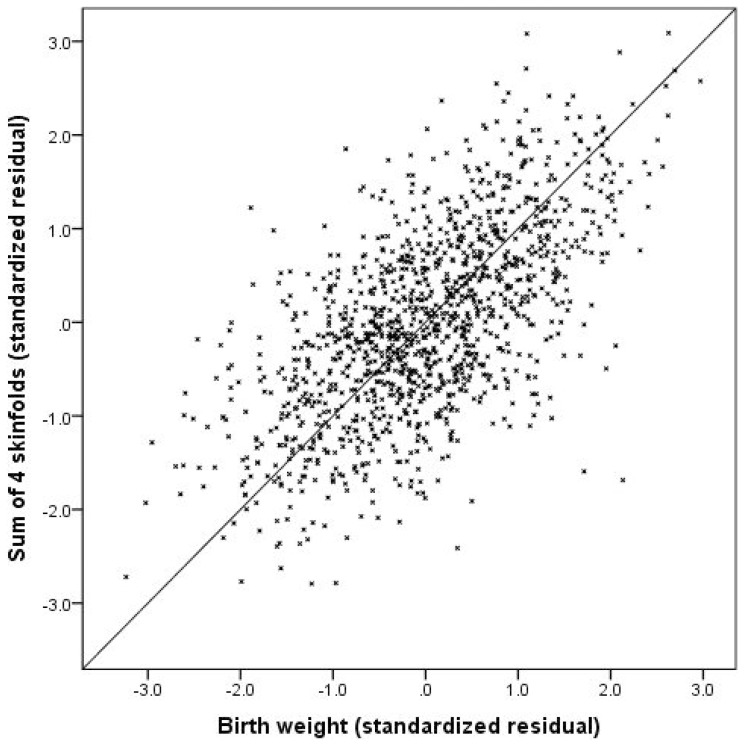
Scatterplot of sum of 4 skinfolds against birth weight.Data are standardised residuals from regression analysis to adjust log transformed anthropometry for sex and gestational age.